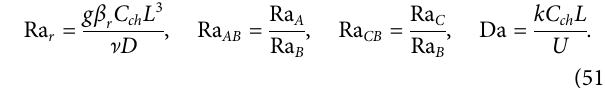
Frontiers in Physics |